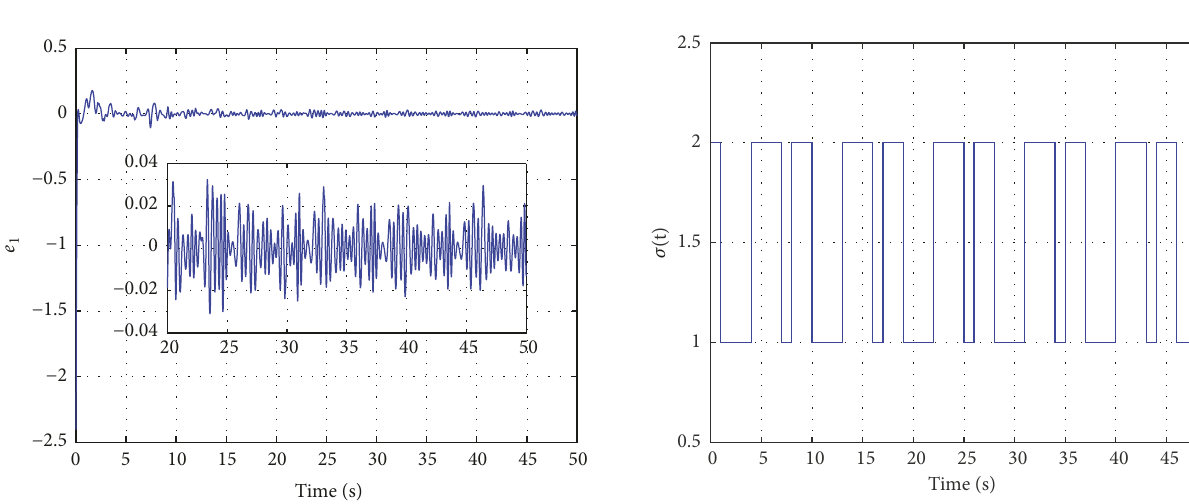
Figure 1: Trajectories of system output signal 𝑦(𝑡) (solid line) and reference signal 𝑦 𝑟 (𝑡) (dash-dotted line).